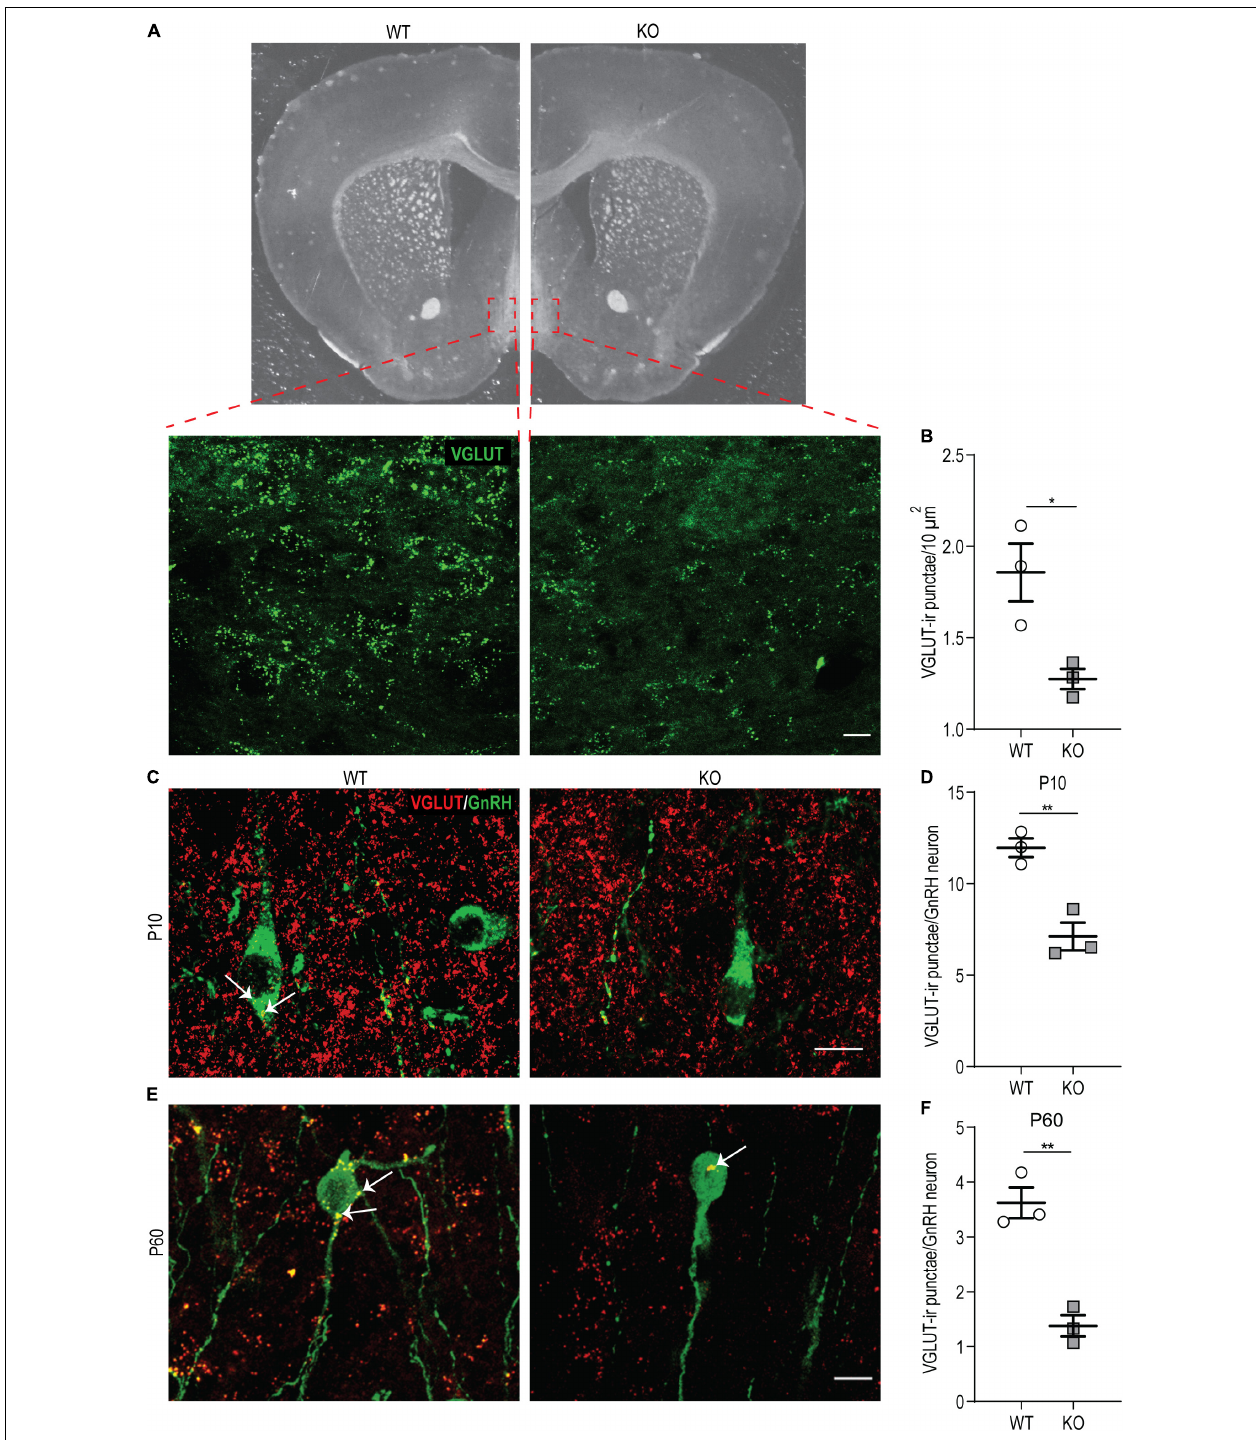
FIGURE 7 | p140Cap KO females show reduced density of VGLUT-ir punctae in the hypothalamus. (A) Maximum intensity projections of z-stack images (20 serial image planes; z step size = 0.5 µ m) of VGLUT-ir punctae in the OVLT of p140Cap KO and WT mice. Scale bar: 20 µ m. (B) Average number of VGLUT-ir punctae per 10 µ m 2 in the OVLT and POA of p140Cap KO and WT mice. n = 3 WT mice; 3 p140Cap KO mice; at least 10 sections were analyzed for each mouse. Unpaired, two-tailed t -test, P = 0.03. (C) Maximum intensity projections of z-stack images (20 serial image planes; z step size = 0.5 µ m) of VGLUT-ir punctae (red) and GnRH neurons (green) in P10 p140Cap KO and WT mice. Arrows indicate VGLUT-ir punctae on GnRH neurons. Scale bar: 10 µ m. (D) Average number of VGLUT-ir punctae on GnRH neurons in P10 p140Cap KO and WT mice. n = 3 WT mice; 3 p140Cap KO mice; at least 30 GnRH neurons were analyzed for each